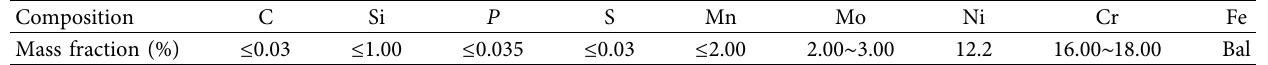
Table 1: Chemical components of 316L stainless powder.